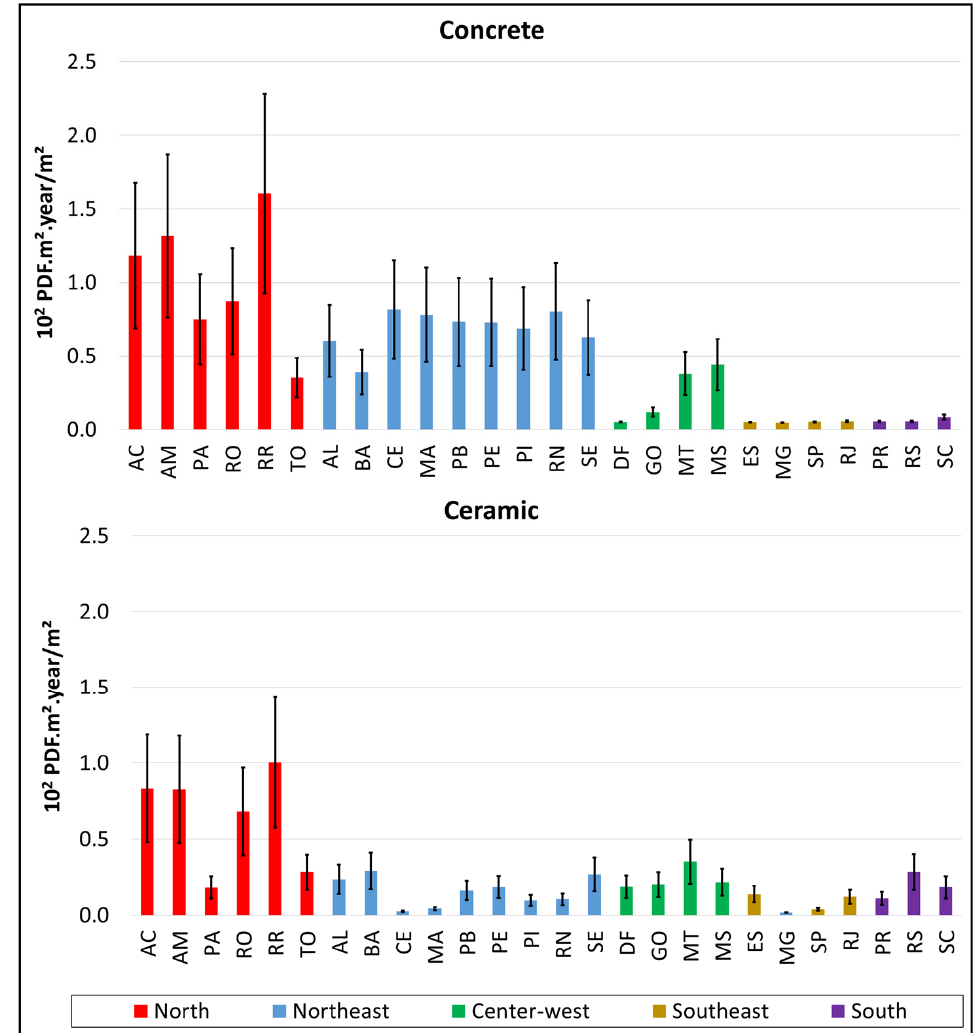
Figure 5. Total Ecosystem Quality impact. The error bars represent the standard deviation due to transportation scenarios.